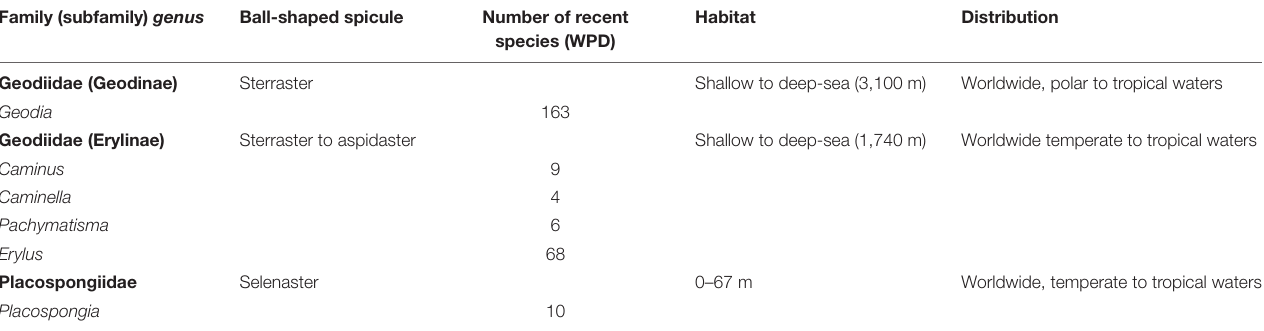
TABLE 1 | Overview of demosponge groups with ball-shaped